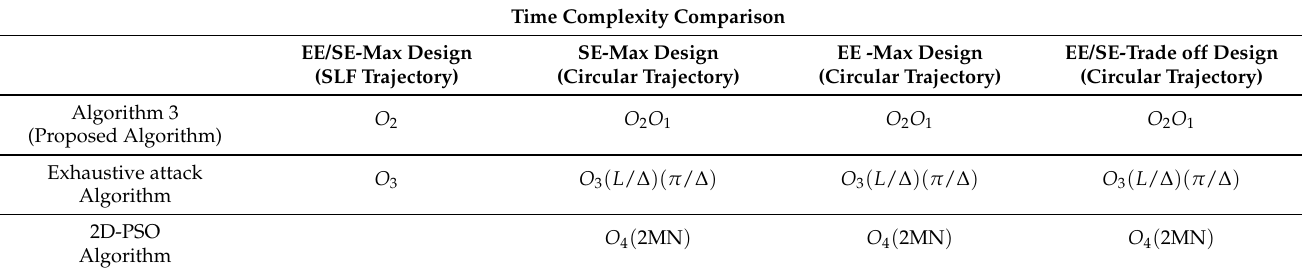
Figure 4. Proposed algorithm vs. some benchmark schemes. ( a ) SE comparison. ( b ) EE comparison. Table 2. Time Complexity